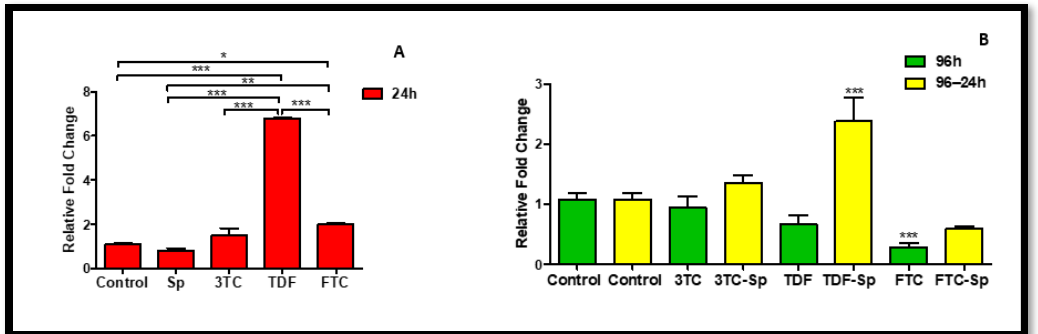
Figure 6. Effects of SP and HAART (3TC, TDF, and FTC) on JNK mRNA expression. JNK mRNA